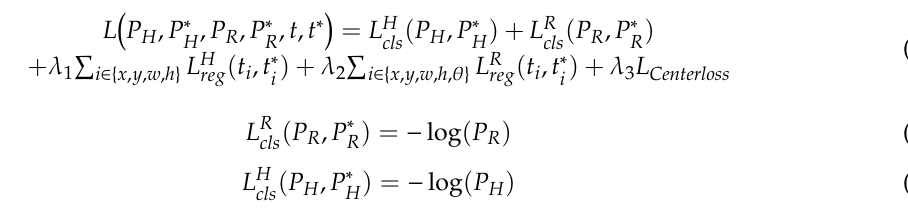
(cid:80) ∗ ( t ) L R i , t i ∈{ x , y , w , h , θ } reg i Centerloss in